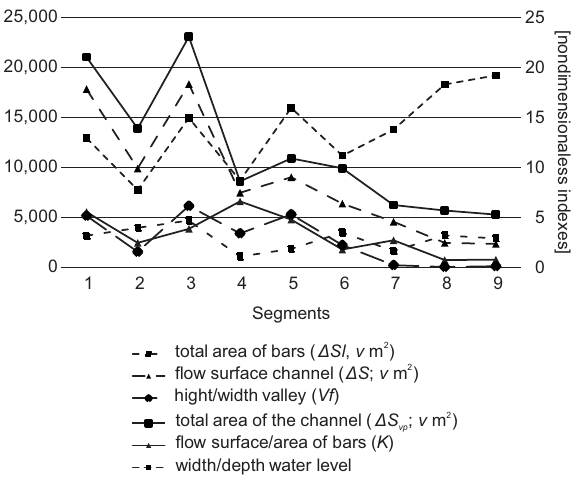
fig. 5. Graph of individual parameters in the Oľšava flow measured section. Left axis: total area of bars ∆ Sl [m 2 ], total area of the channel ∆ S [m 2 ], flow surface channel ∆ S [m 2 ]. Right vp axis: height/width valley Vf , width/depth water level, and flow surface/area of bars K